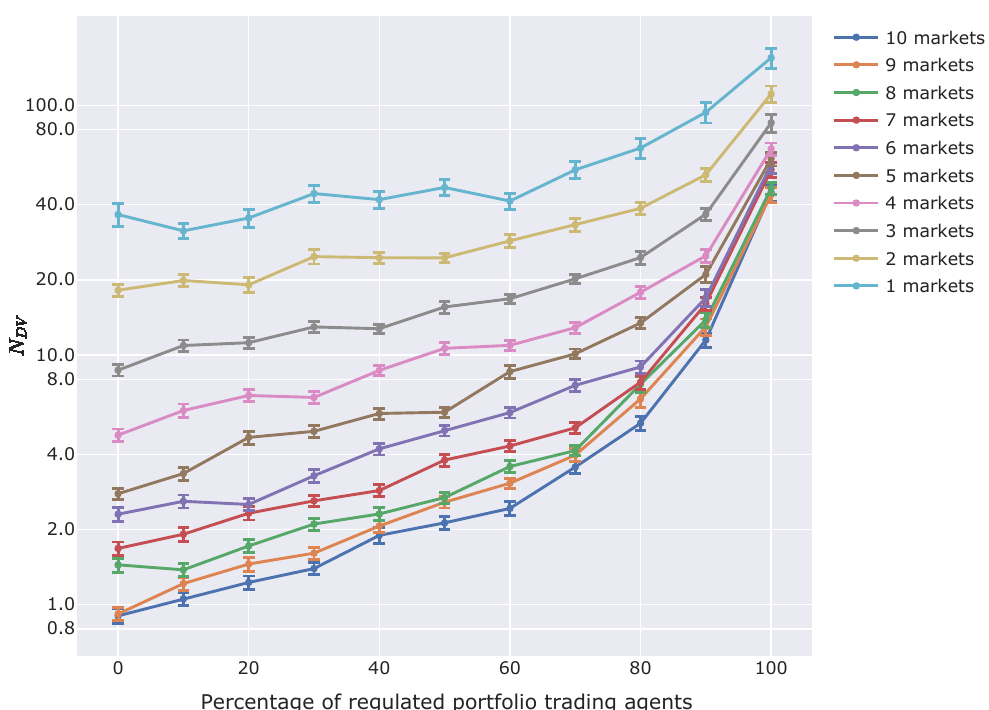
Figure 8. N DV graph assessing the effect of CAR regulation. The horizontal axis is the percentage of regulated portfolio trading agents among all non-regulated and regulated portfolio trading agents. The vertical axis is the number of steps in which the market price is below exp ( − 0 . 5 ) times the fundamental price. (Details are explained with Equation (15)). Each series of plots shows a simulation series for a certain number of markets. Error bars show standard deviations. Please note that the vertical axis is